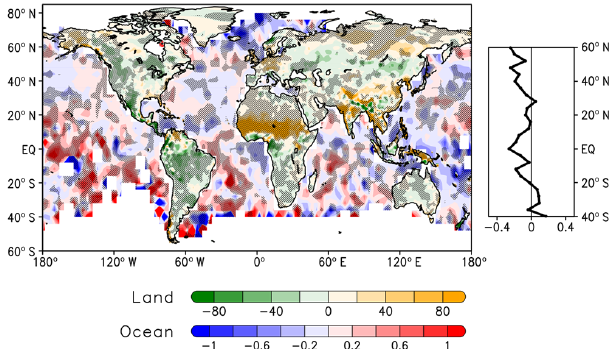
Figure 6. (Left) trend shifts in scalar wind speed over the ocean (ms − 1 10 years − 1 ) and (right) latitude profile of its zonal mean. Land areas display trend shifts in JAS precipitation from Fig. 3a. Hatching represents areas where trends changed sign between the two parts of the study period (tan θ 1 · tan θ 2